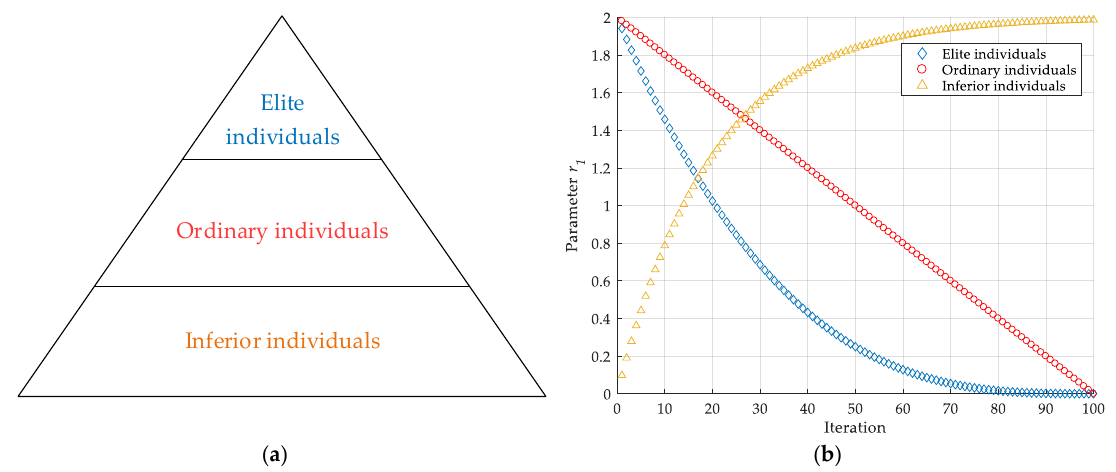
Figure 3. Schematic diagram of the proposed adaptive sine cosine algorithm (ASCA) based on hierarchical strategy: ( a ) Hierarchy of individuals (fitness value decreases from top down), ( b ) changes of r 1 for individuals of different subgroups.